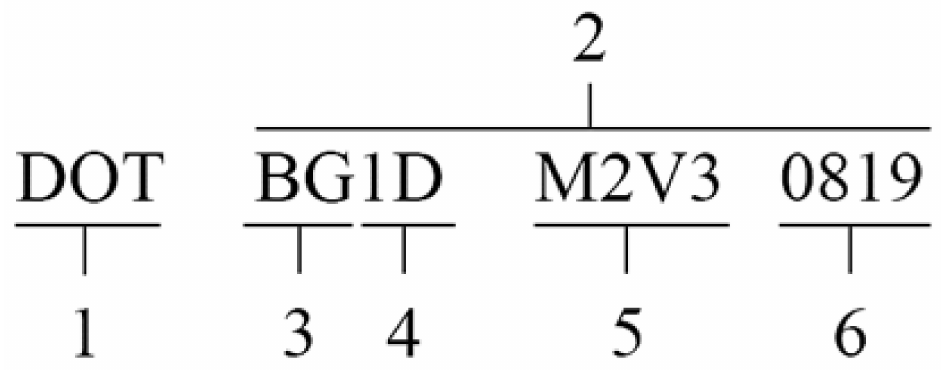
Figure 8. Tire identification number (TIN)—symbols explained in the text above the figure.